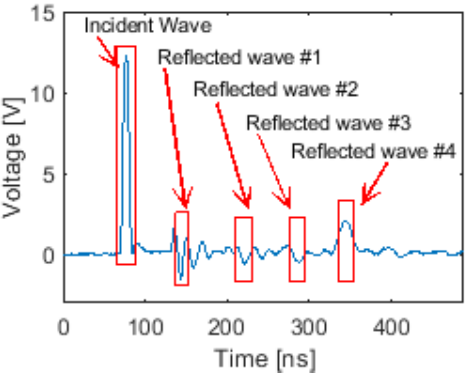
Figure 12. A representative voltage-time history of ETDR testing of a transmission line with three capacitive tilt sensors connected in parallel and in an open-circuit configuration is shown.